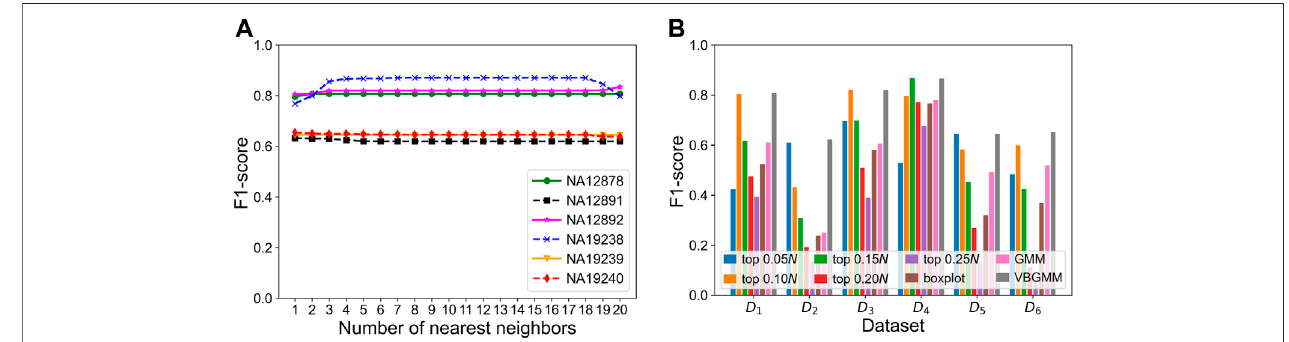
FIGURE 6 | Performance of the KNNCNV in terms of F1-score on the six real datasets. (A) Performance of our method with different the number of nearest neighbors,where1 – 20denote0.05 ,0.10 ,0.15 N , ... ,0.95 N ,and1.00 N ,respectively. (B) Resultwithdifferentthresholdselectionstrategiesundertheframeworkofour method, where D 1 - D 6 denote NA12878, NA12891, NA12892, NA19238, NA19239, and NA19240, respectively. Additionally, the ‘ top n ’ represents a simple threshold scheme, and n belongs to the set {0.05 , 0.10, 0.15, 0.20 , 0.25 N }. Speci fi cally, after the outlier scores are ranked in descending order, the scheme treats the genome segments corresponding to the fi rst n scores as CNVs. Note that 1 – 20 and n are rounded down, and N is the number of genome segments.